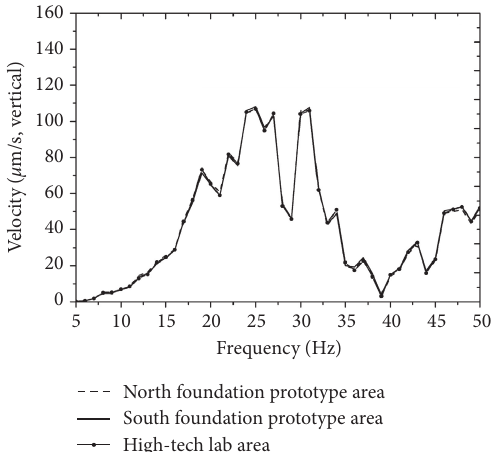
Figure 12: Velocity of free-field ground vibrations.